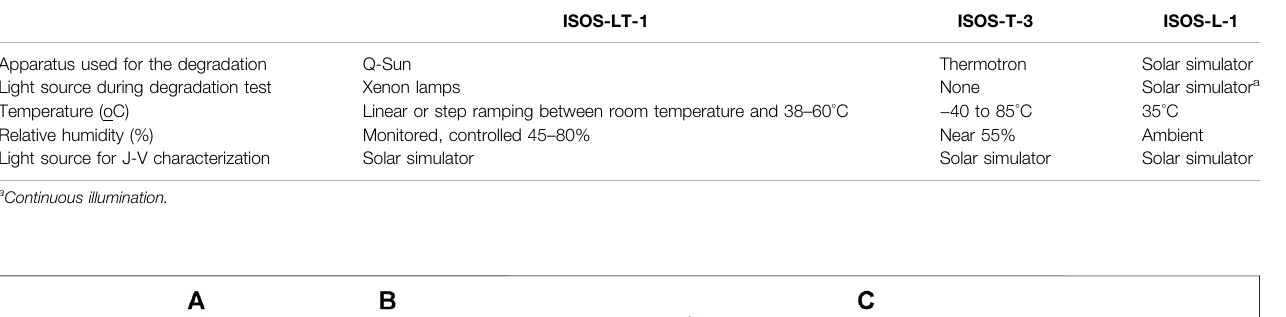
TABLE 1 | ISOS test protocol conditions applied during the degradation experiments.